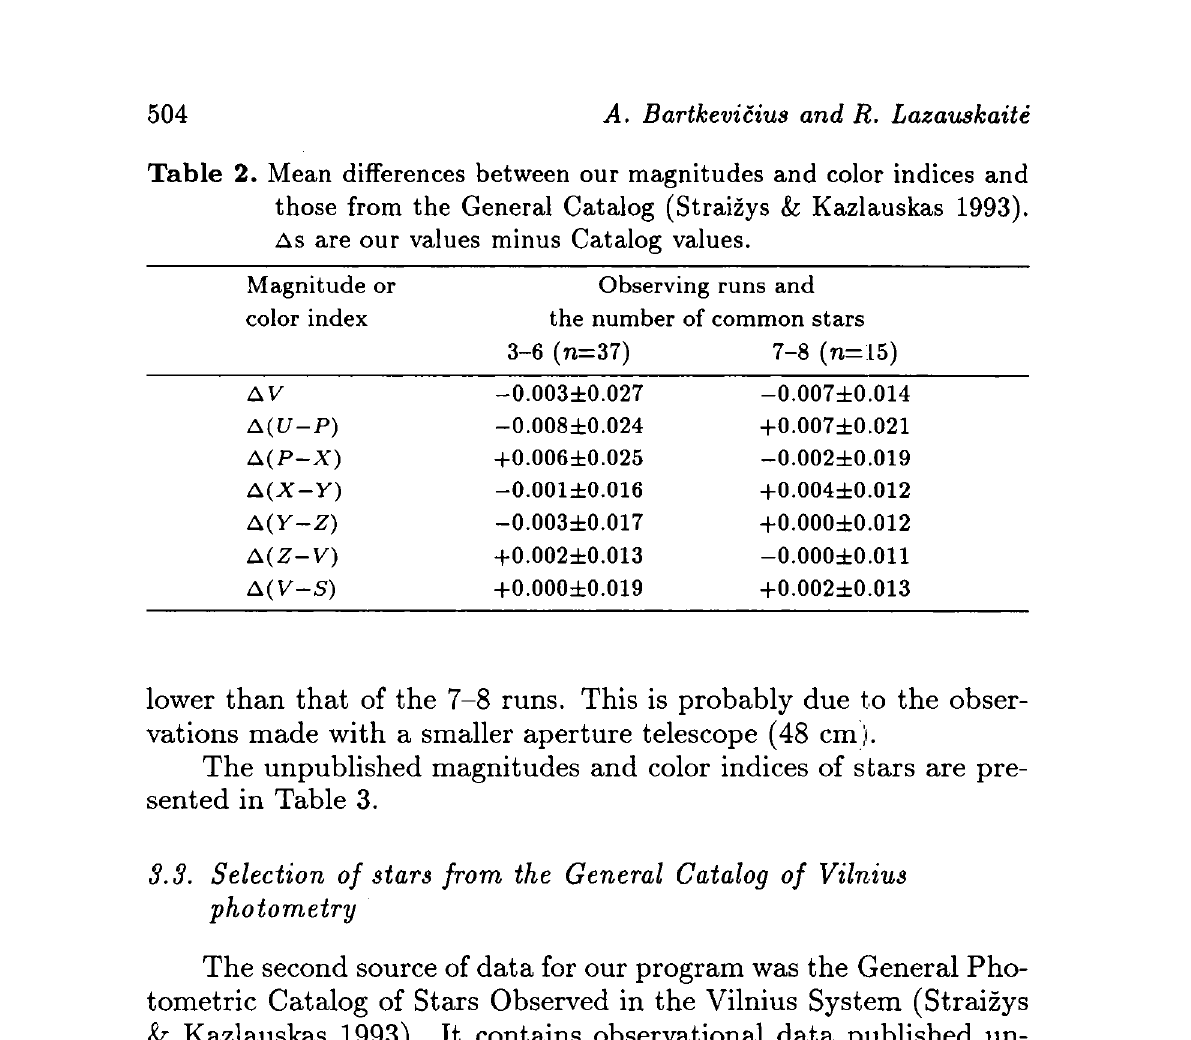
Table 2. Mean differences between our magnitudes and color indices and those from the General Catalog (Straizys & Kazlauskas